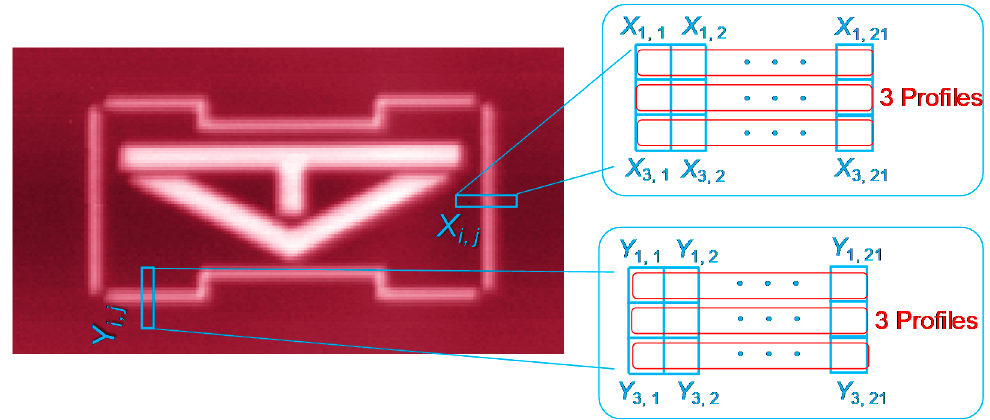
Figure 6. Schematic illustration of extraction of vertical and horizontal profiles from THz image.